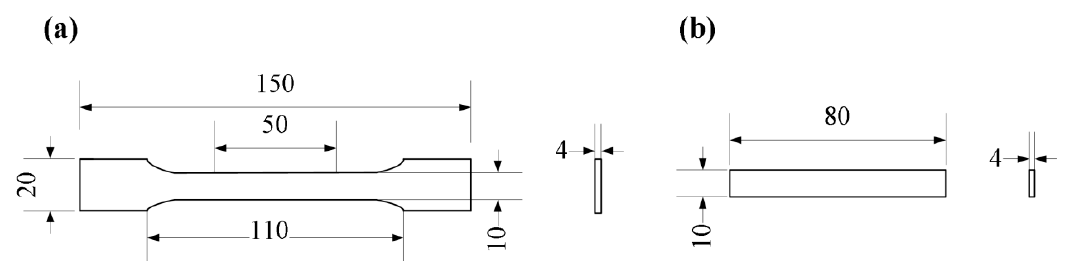
Figure 4. Geometric models of the mechanical test specimens. ( a ) Tensile specimen; ( b ) bending specimen.